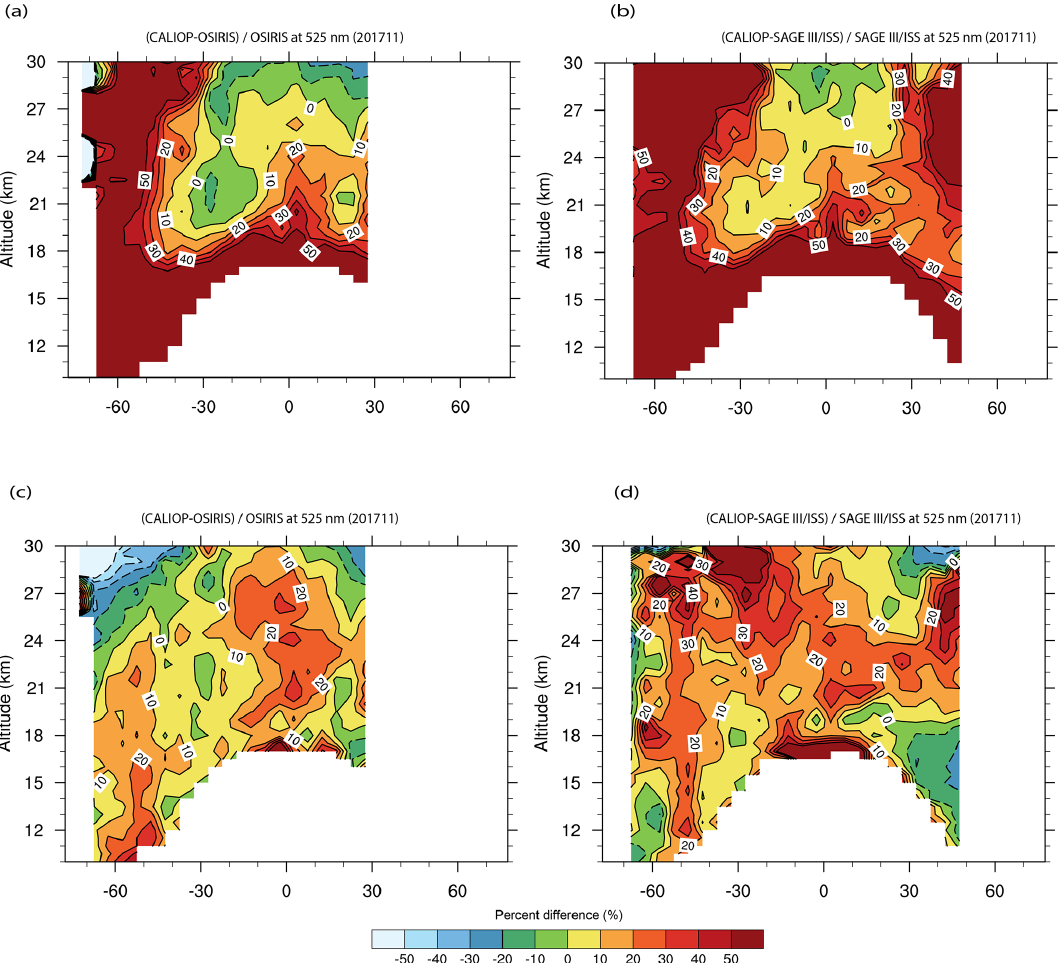
Figure 8. Altitude versus latitude of percent difference between CALIOP, OSIRIS and SAGE III/ISS extinction coefficients. Percent differ- ence computed (a) between the CALIOP and bias-corrected OSIRIS extinction coefficient at 525nm for November 2017 and (b) between the CALIOP and SAGE III/ISS extinction coefficient at 525nm for November 2017. Panels (c) and (d) are the same as in panels (a) and (b) but CALIOP extinction is bias